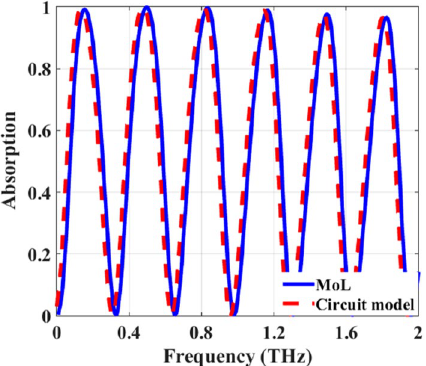
Figure 10. Absorption spectra of the tunable THz absorber of Fig.7b for µ c ( CGS ) = 0.25 eV, µ c ( PAGS ) = 0.125 eV, τ = 0.1 ps and T = 300 K.